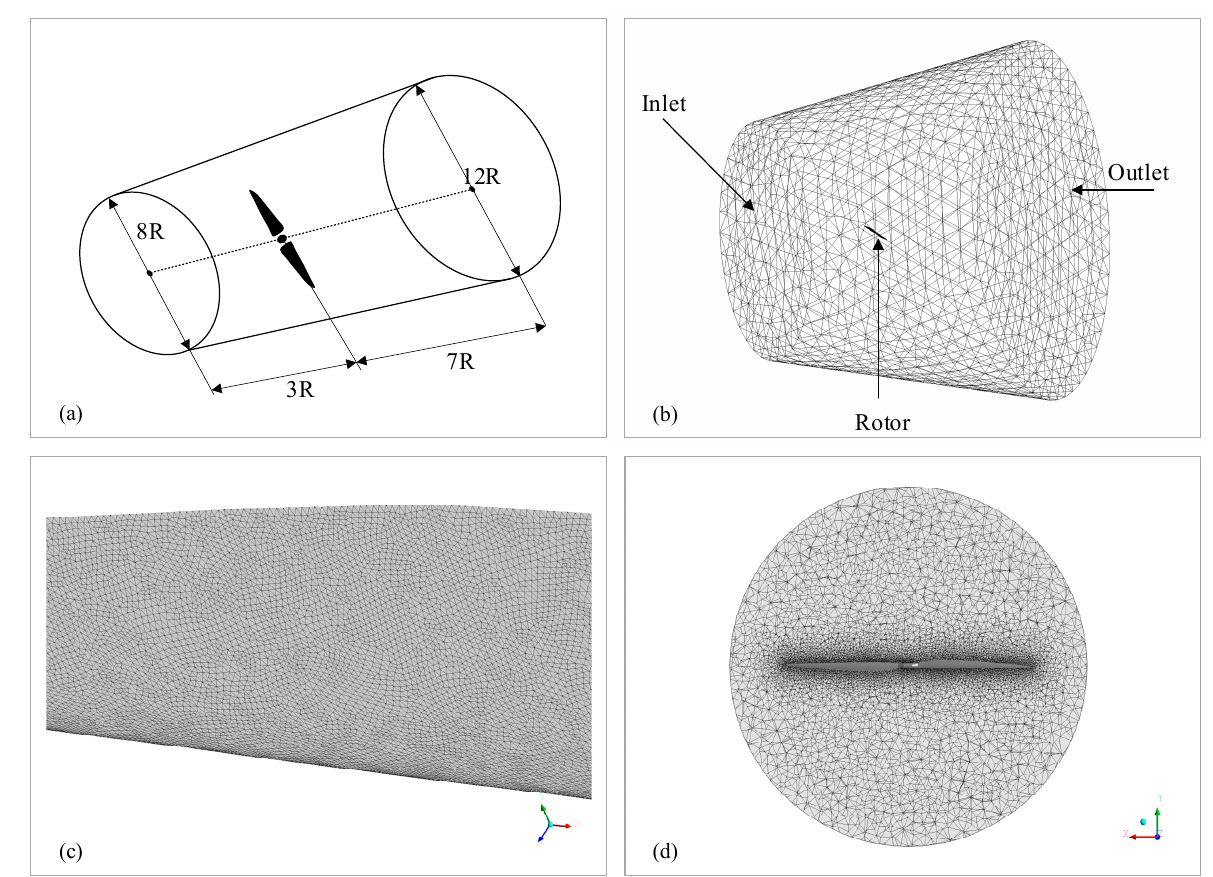
Figure 9. Flow field settings of the Two-BWT. ( a ) Flow field space settings; ( b ) Flow field meshing; ( c ) Blade surface meshing; ( d ) Local area mesh for wind rotor.